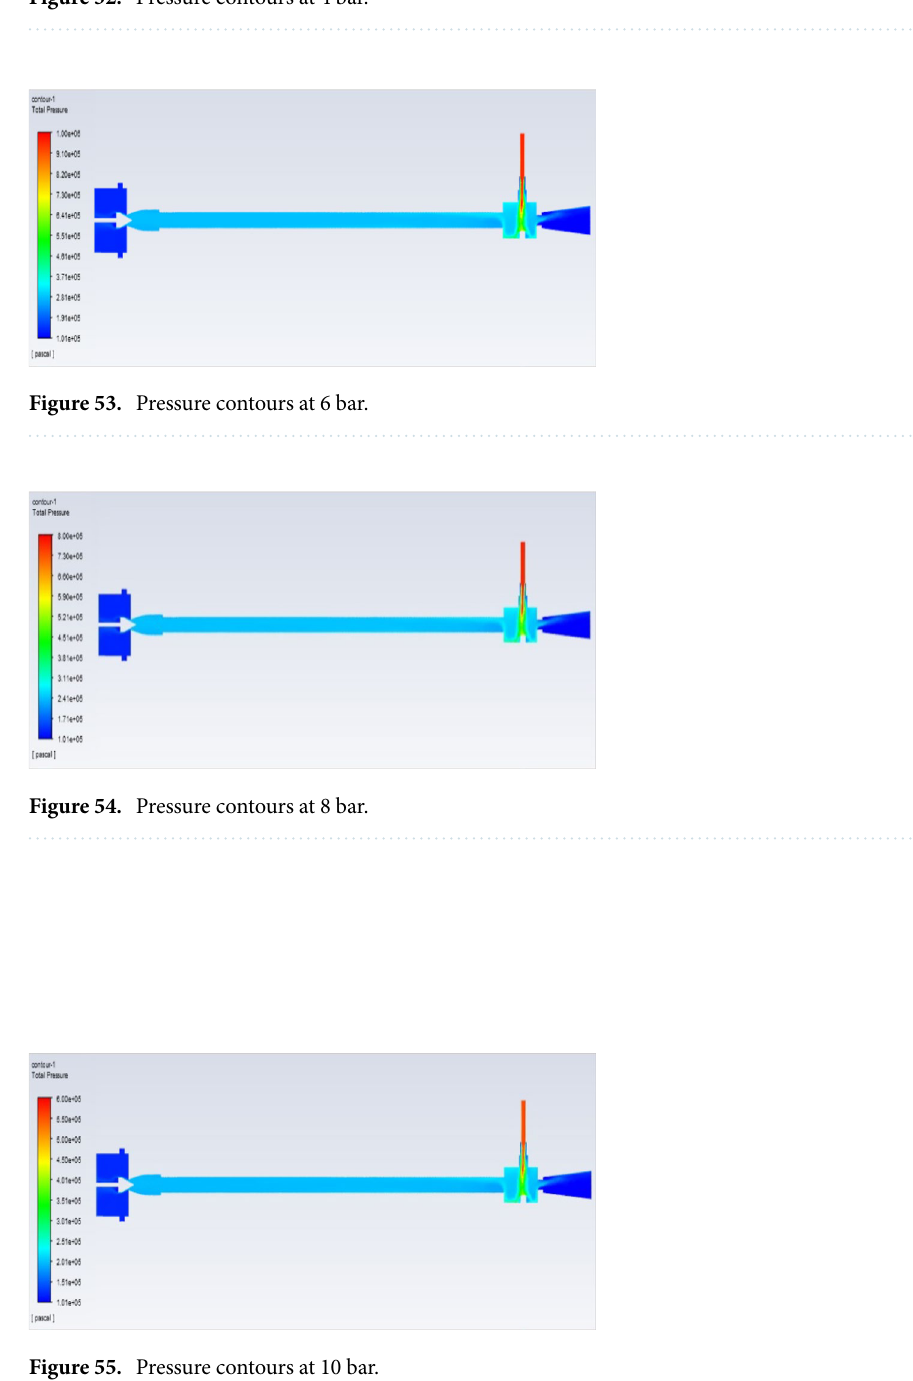
Figure 52. Pressure contours at 4 bar.